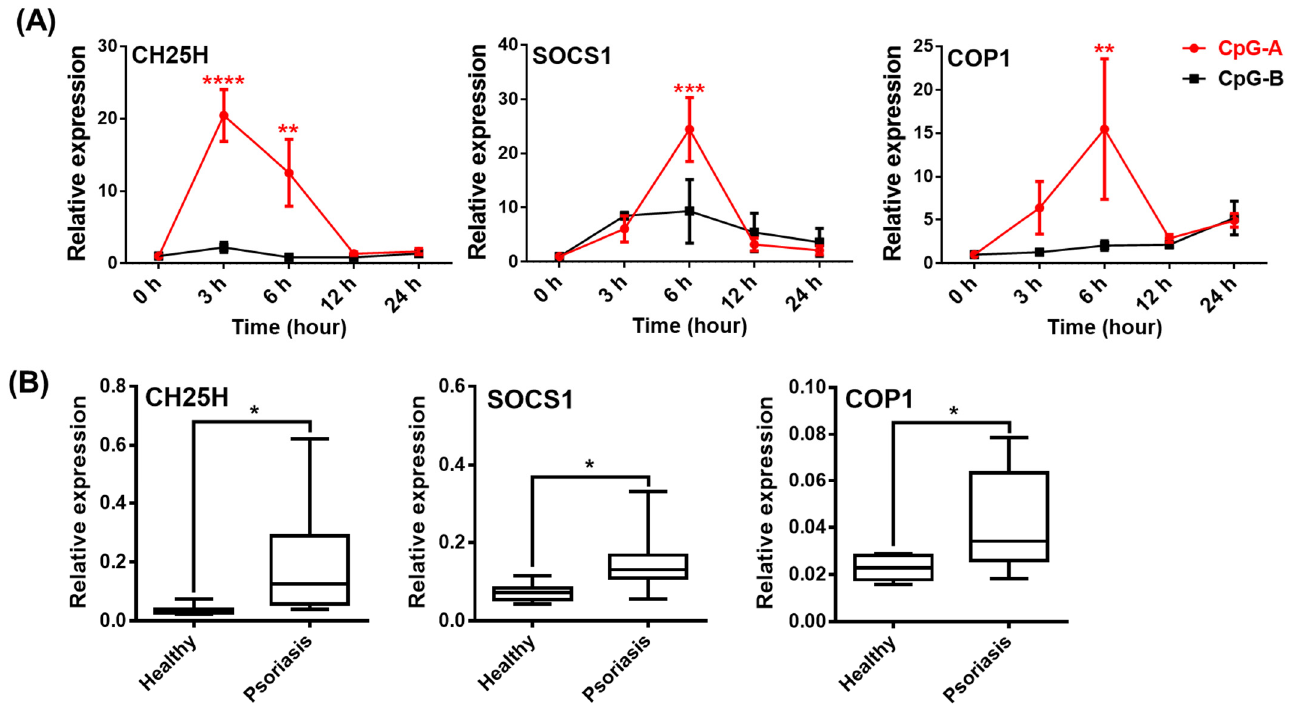
Figure 10. Various NLRP3 pathway inhibitors are induced by the powerful type I IFN inducer TLR9 ligands and show elevated levels in psoriasis patients. GEN2.2 cells were treated with 1 µ M CpG-A or 1 µ M CpG-B in a time-dependent manner and the expression of CH25H , SOCS1 and COP1 was measured by qPCR ( A ). PBMCs were isolated from the peripheral blood of healthy volunteers and psoriasis patients and the relative expression of CH25H , SOCS1 and COP1 was determined by qPCR ( B ). Bar graphs represent the mean ± SD of 4–14 independent experiments. Data were analyzed using one-way ANOVA followed by Bonferroni’s post hoc test ( A ) or paired Student t test ( B ). * p < 0.05, ** p < 0.01, *** p < 0.001, **** p < 0.0001 vs control (ctrl) or healthy control.